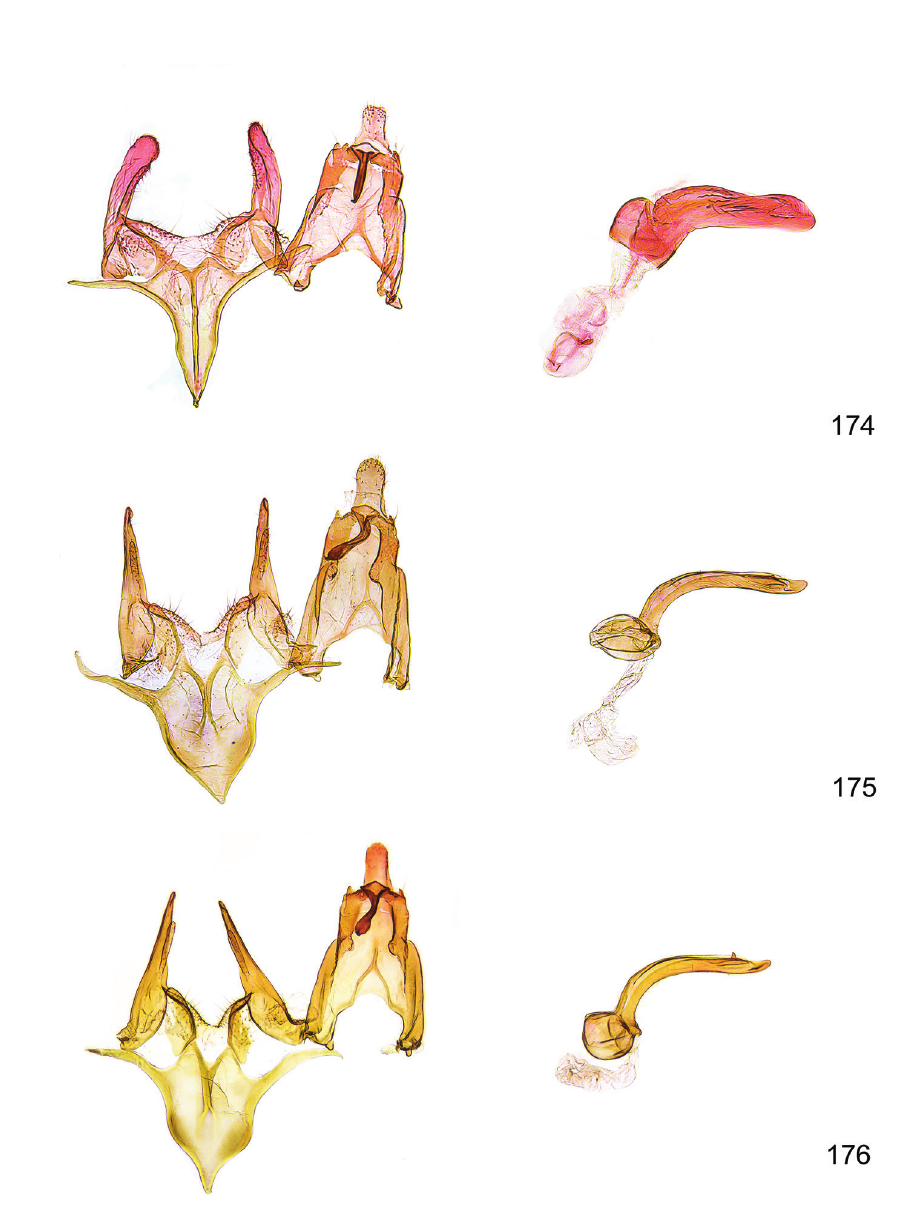
Figures 174–176. Megacraspedus male genitalia. 174 M. faunierensis sp. n. – Paratype,